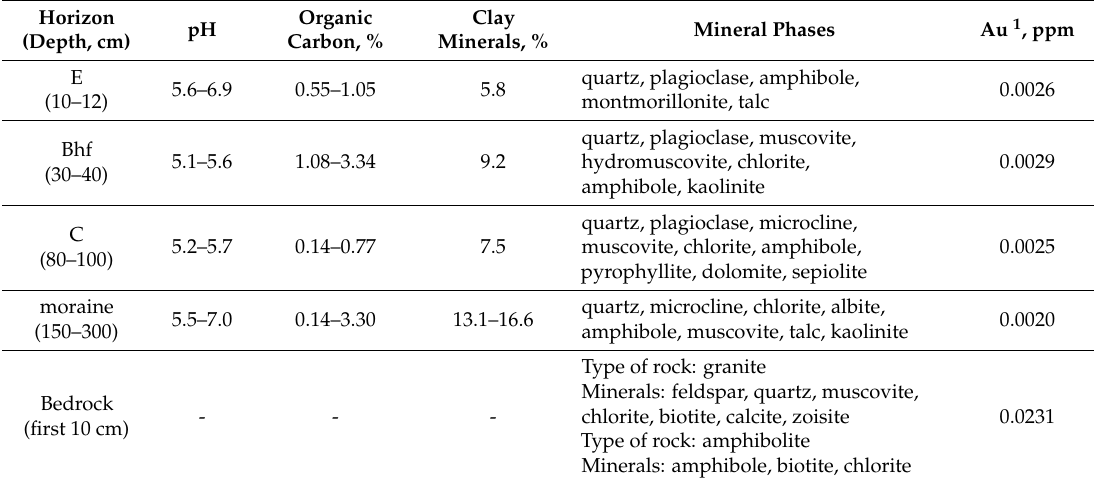
Table 2. The main chemical and mineralogical overburden and bedrock properties in the Piilola prospecting area.